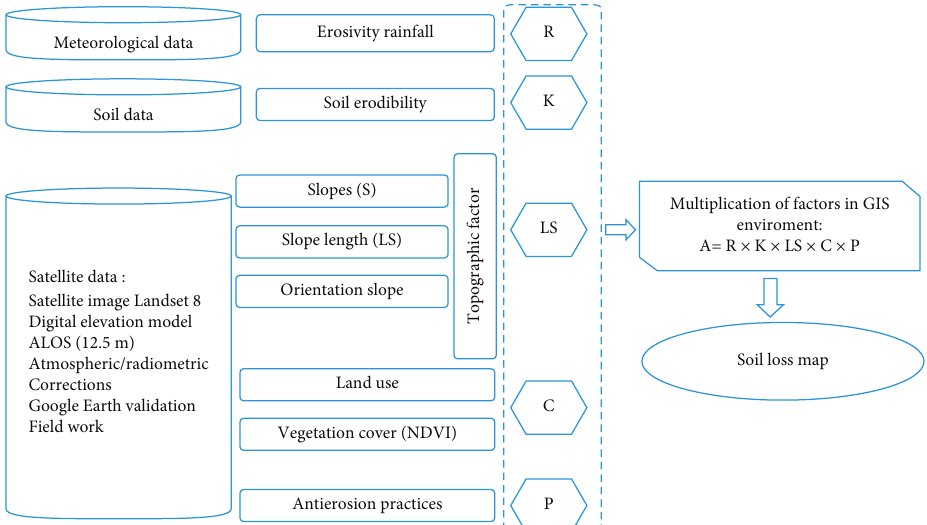
Figure 2: The methodological framework of the RUSLE method.